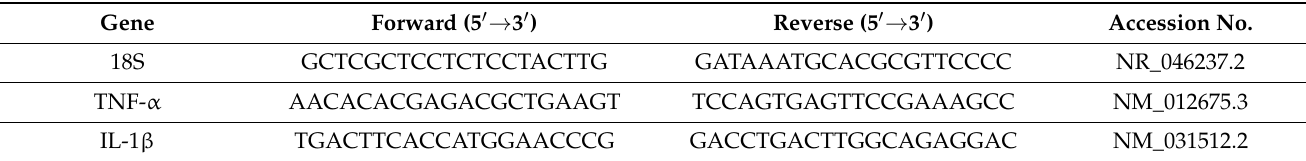
Table 1. Primers used for